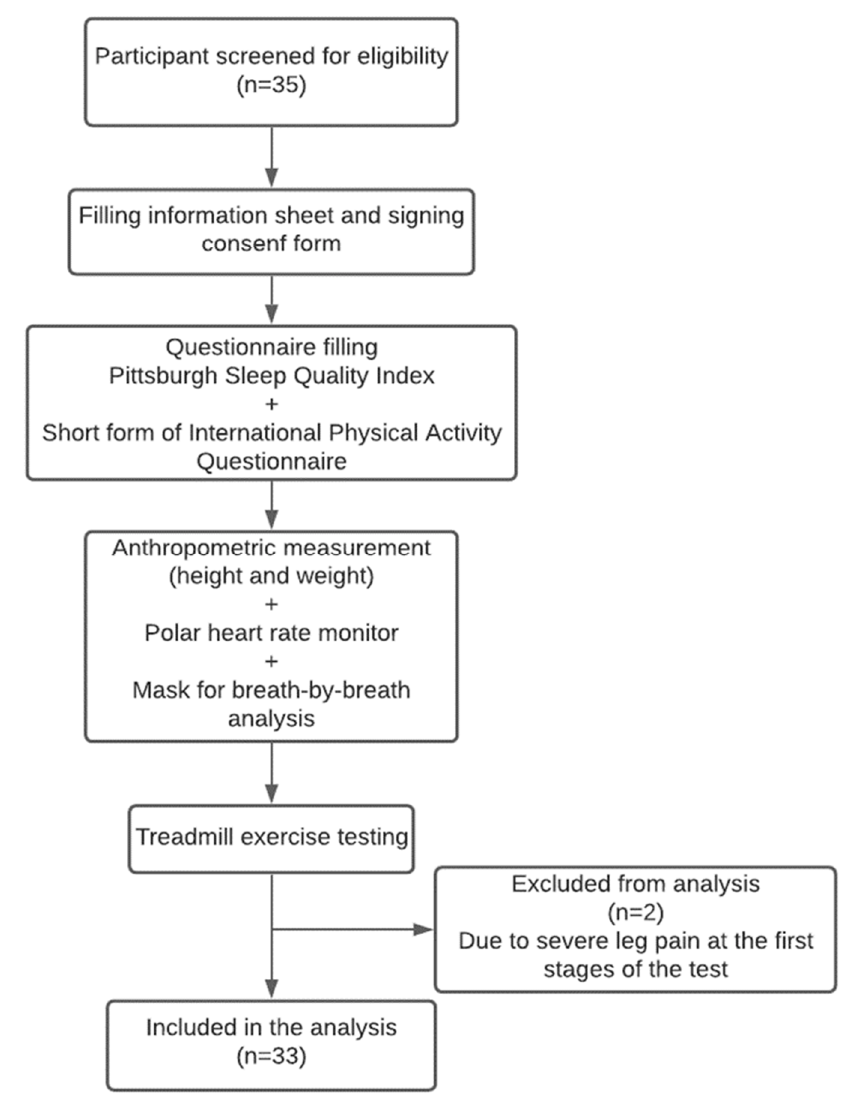
Figure 1. Flow diagram of the study protocol.